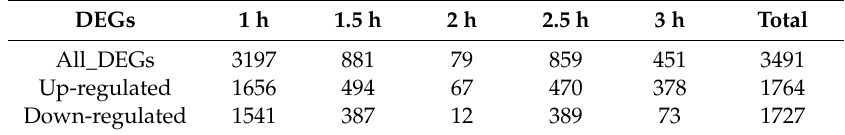
Table 1. Di ff erentially expressed genes (DEGs) under di ff erent low-temperature stress time points.